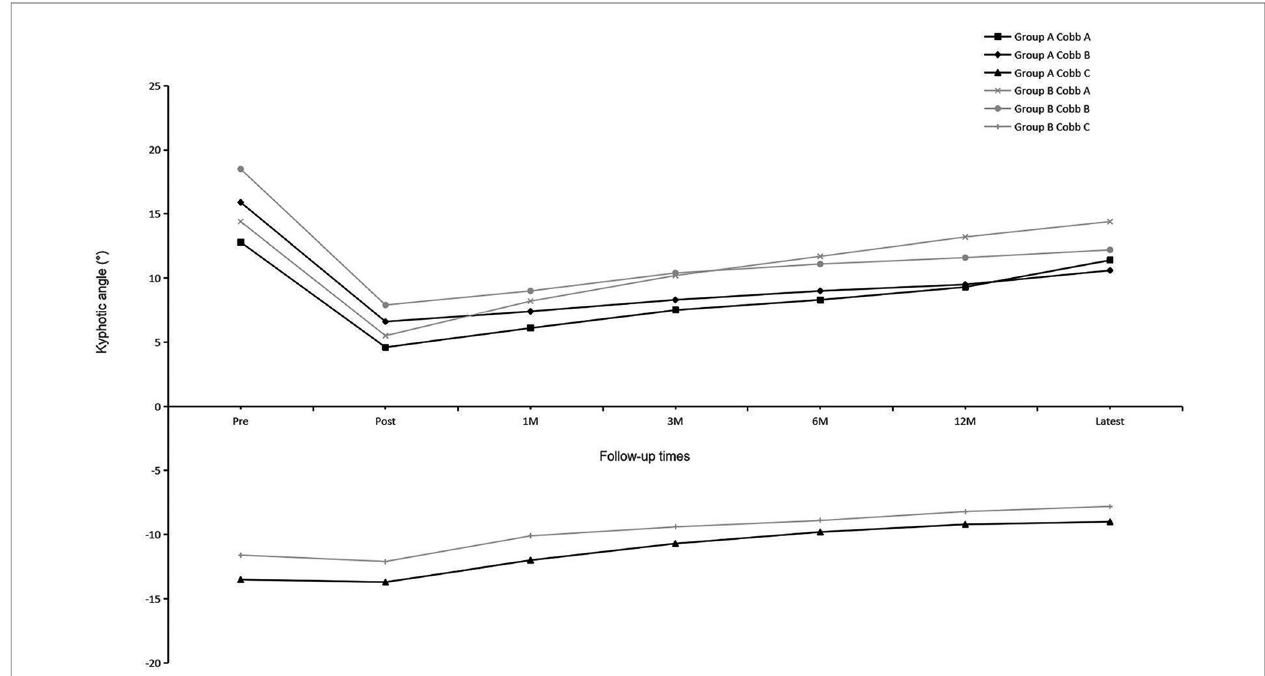
FIGURE 2 | Mean kyphotic angles (Cobb A, Cobb B, and Cobb C) of the two groups at each time